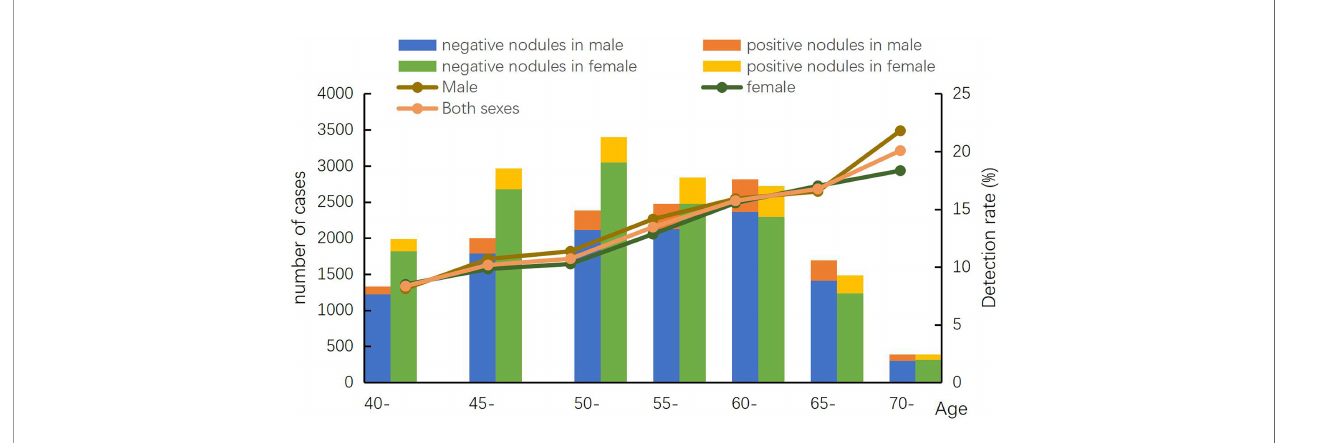
FIGURE 2 | Age-speci fi ed positive nodules detection rate in Hebei